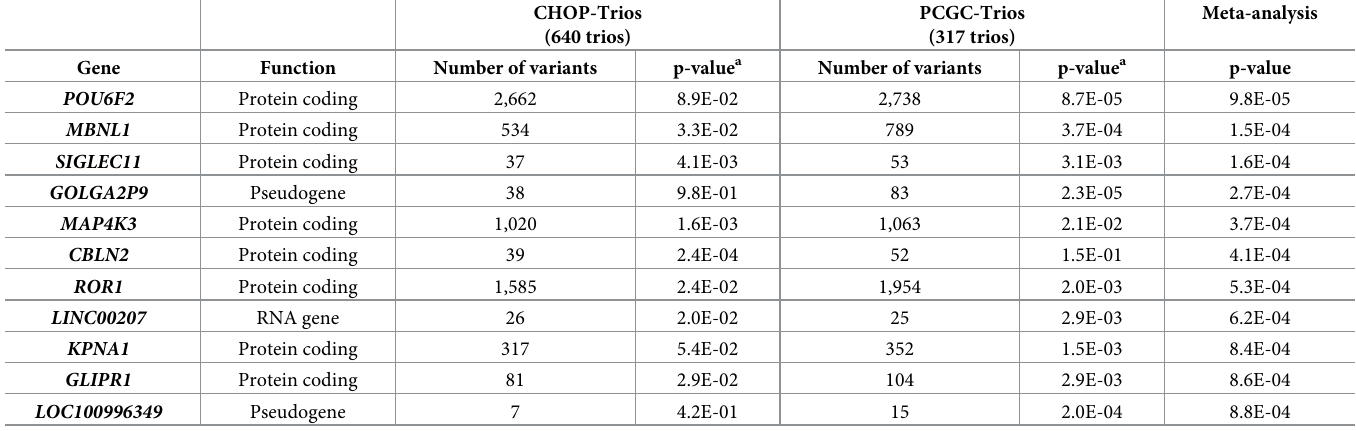
Table 3. Genes with suggestive evidence of association (p < 1E-03) in the trio-based